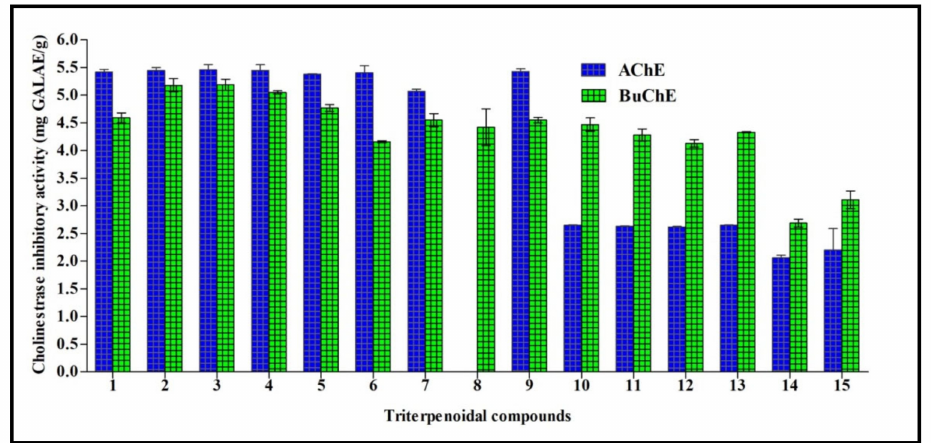
Figure 3. Cholinestrase inhibitory activity of fifteen triterpenes expressed in mg GALAE/g. Values are reported as mean ± S.D.; GALAE: Galatamine